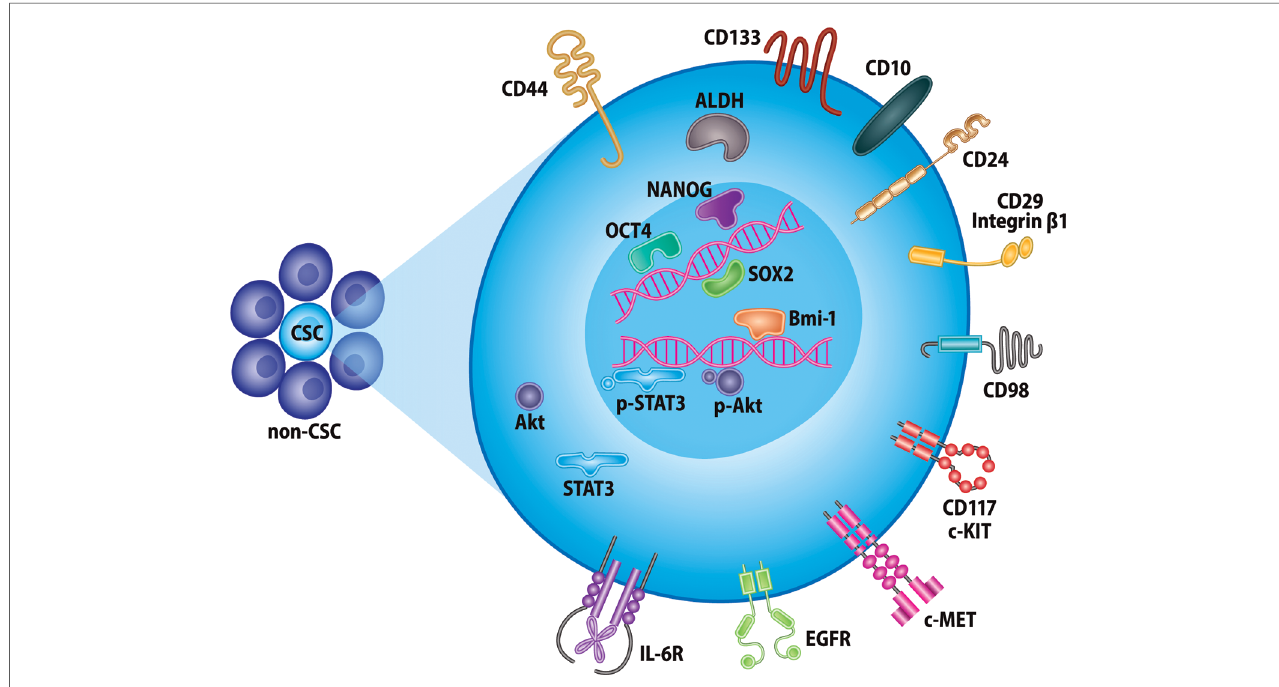
FIGURE 1 Markers of head and neck cancer stem cells. Selected proteins currently used for identi fi cation of CSCs in head and neck cancer. These include, but are not limited to, various cell-surface glycoproteins, receptor tyrosine kinases, intracellular enzymes, and transcription